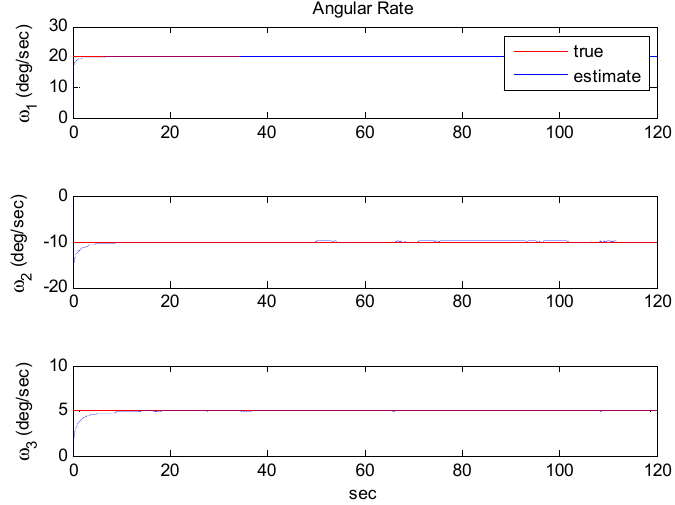
Figure 8. Angular rate estimation with close initial conditions: Case